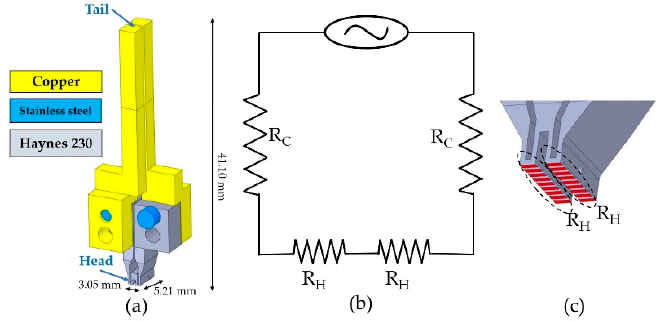
Figure 5. A series welding tip for ( a ) overview, ( b ) electric flow direction, and ( c ) enlarged head.